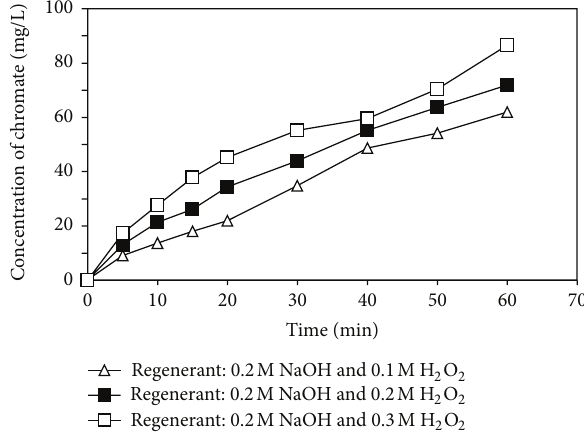
Figure 2: The regeneration efficiency depends on the amount of regenerant solutions. (The amount of exhausted resin; 2.0 g; the speed of the stirrer; 200rev./min; the volume of regenerant solution is 2.0 L) (serie II).